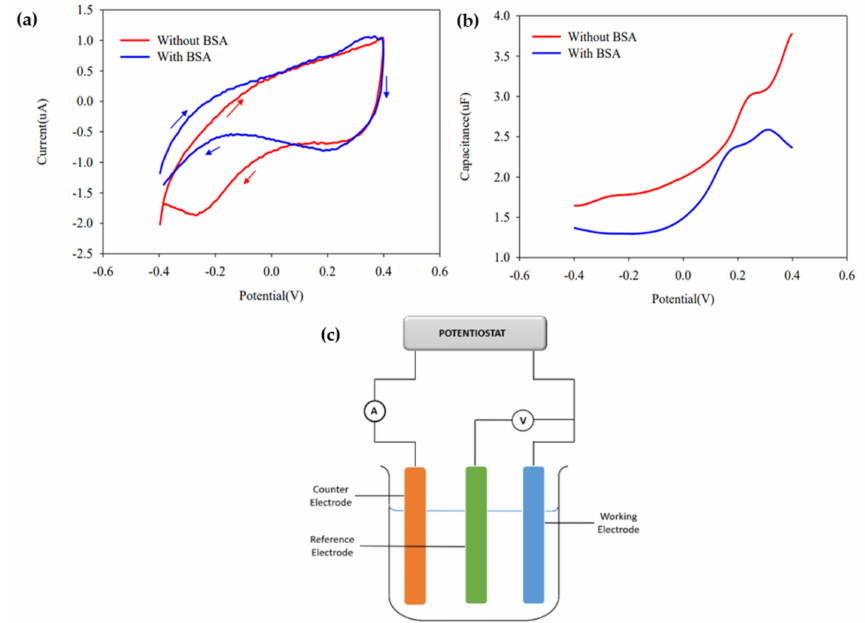
Figure 8. ( a ) The voltammogram graph, ( b ) the curve measurement of capacitance. The potentiostat can do both measurements ( c ) Three types of electrodes dipped into the analyte for CV. Adapted with permission from Ref. [102], Madduri